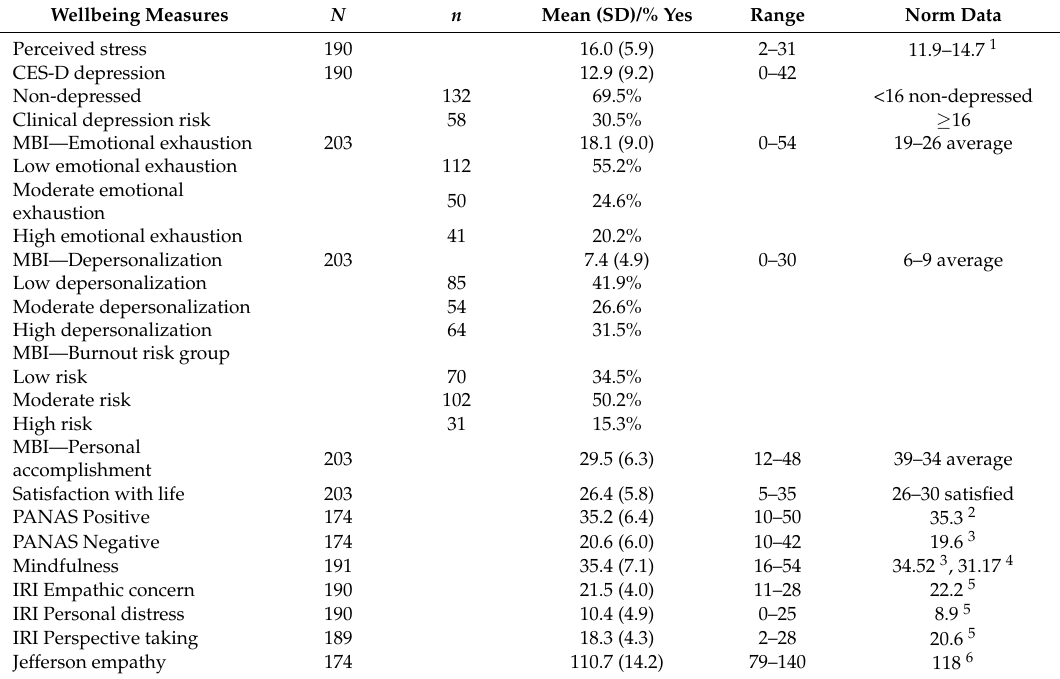
Table 2. Measures of wellbeing—descriptive